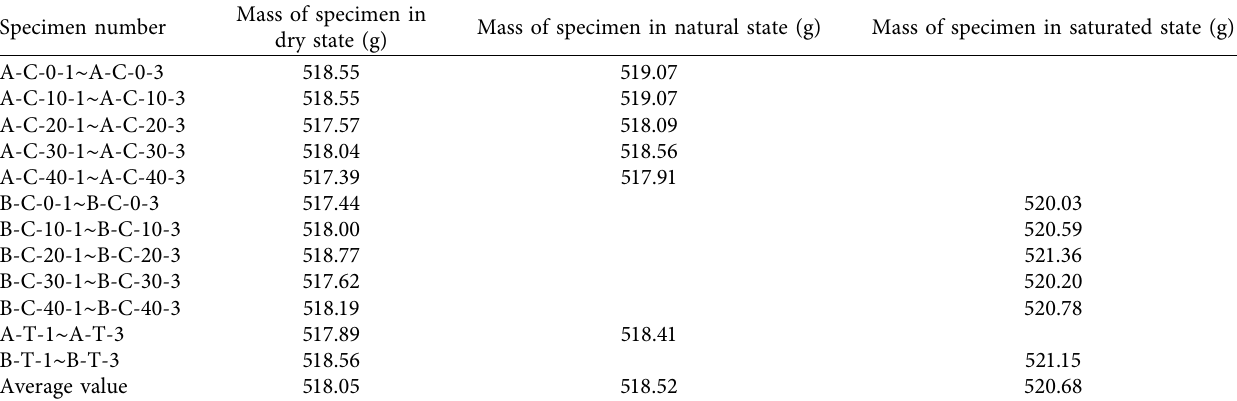
Table 1: Mass of all specimens in the dry state, natural state and saturated